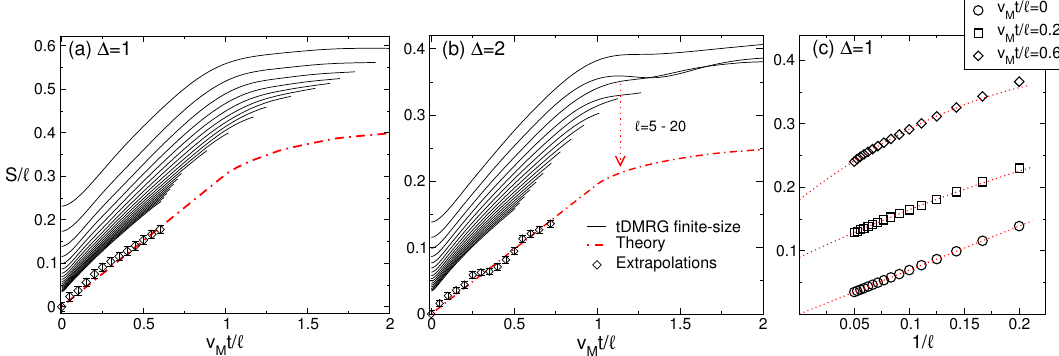
Figure 7: Post-quench dynamics of the von Neumann entanglement entropy in the XXZ spin chain: Comparison with tDMRG results. Here the entanglement entropy density S /(cid:96) , with (cid:96) t /(cid:96) , with v the subsystem size, is plotted against the rescaled time v being the maximum M M velocity in the system. All the results are for the quench from the Néel state. Panel (a). Results for ∆ = 1. Continuous lines are tDMRG results for a chain with L = 40. Different lines correspond to different block sizes (cid:96) = 5 − 20. The dashed line is the Bethe ansatz result in the scaling limit t , (cid:96) → ∞ with x / t fixed. The diamonds are the numerical extrapolations (see panel (c)) in the thermodynamic limit. Panel (b). The same as in (a) for ∆ = 2. Panel (c). Numerical extrapolations of the tDMRG results in (a) in the thermodynamic limit. The t /(cid:96) (different symbols). The curves are fits panel plots S /(cid:96) versus 1 /(cid:96) for several values of v M to a + b /(cid:96) + c /(cid:96) 2 with a , b , c fitting